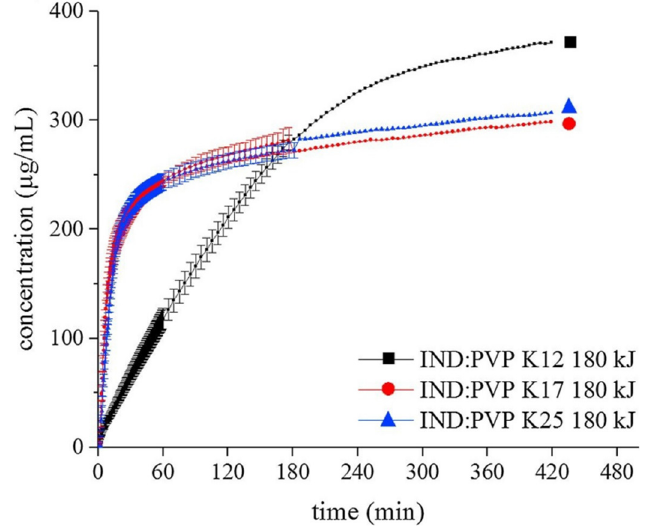
Figure 4. Dissolution profiles of IND:PVP K12, IND:PVP K17 and IND:PVP K25 compacts after microwaving with an energy input of 180 kJ. (Reproduced from [46]).